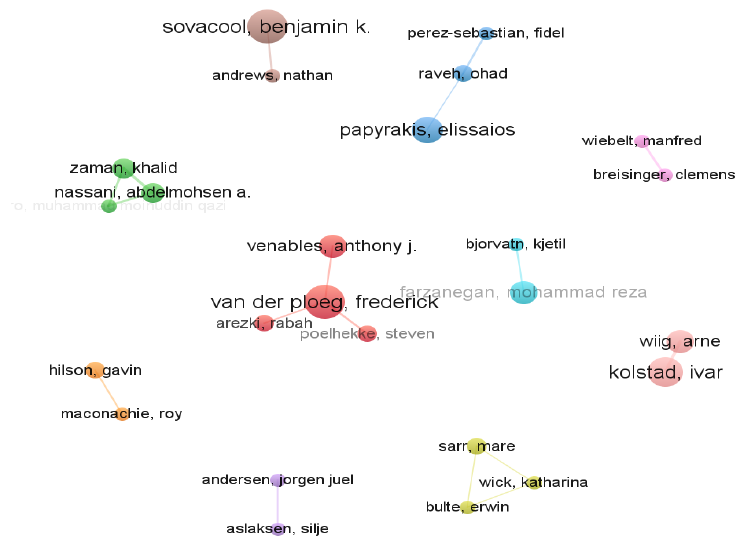
Figure 10. The scholars’ co–authorship.